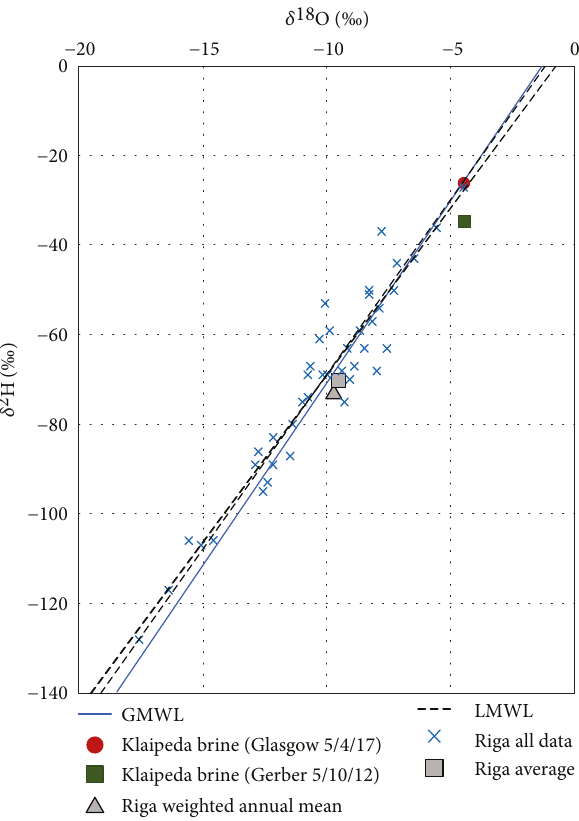
Figure 4: Stable 18 O and 2 H data for the water sample documented from October 2012 [17] and the water sample of 5/4/17 analysed in Glasgow, compared with available monthly data for isotopic composition of precipitation from the WMO Riga meteorological station (station no. 2642200, 1980-89). The dashed lines show possible interpretations of the local meteoric water line (LMWL) and global meteoric water line (GMWL). Data from [20]. Note that Quaternary intertill aquifers in eastern Lithuania typically contain groundwater with a δ 18 O of -10.0 to -11.2% (i.e., similar to meteoric water [21]). Lithuanian Devonian aquifers [22] of < 500m depth typically contain groundwater with δ 18 O of -10.2 to -13.0%; below 500 m depth, the signatures become less negative (as high as -4.5% in borehole Naumiestis 1). See also